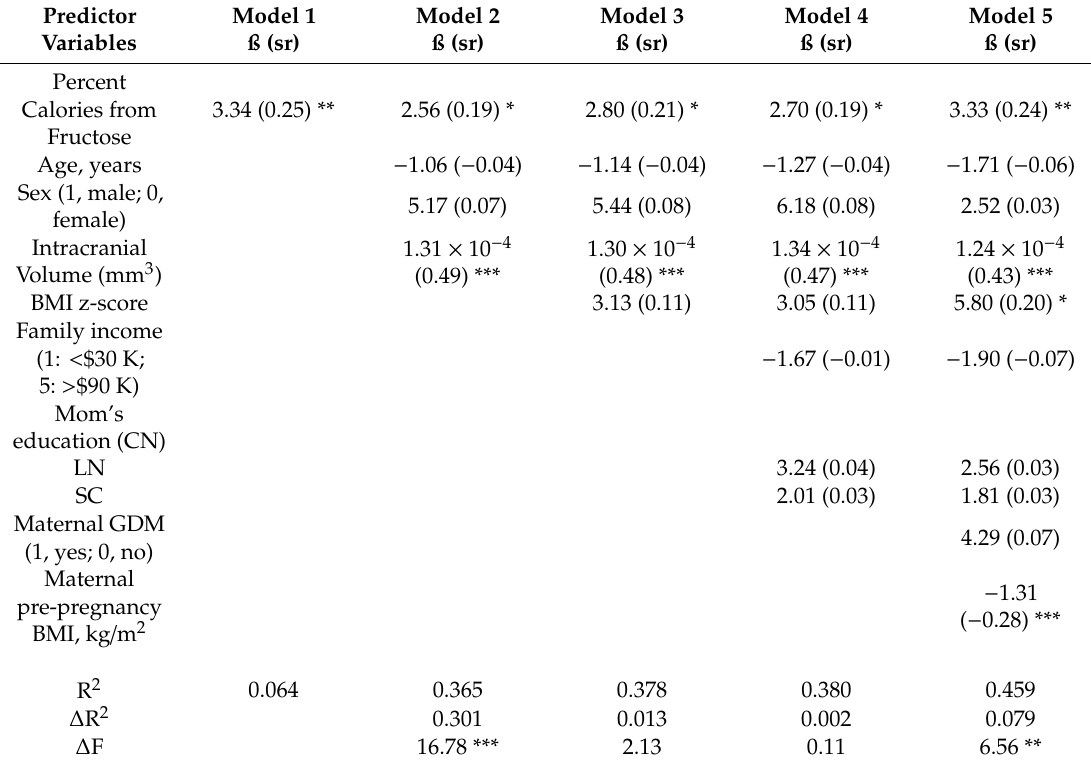
Table 3. Associations between dietary fructose intake and the volume of right CA2 /